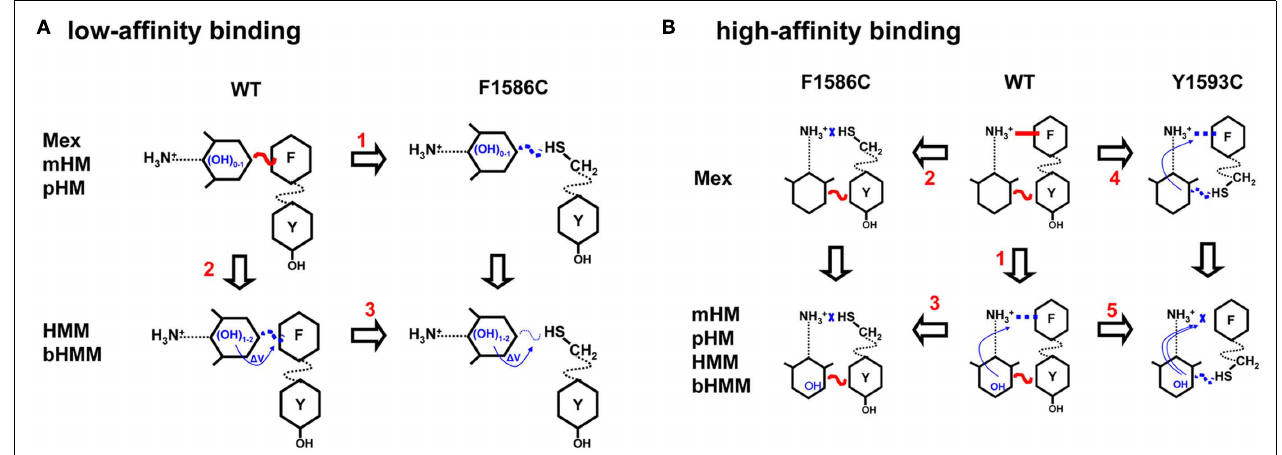
parameters (arrow 2).The F1586C mutation produces additional weakening of the interaction with HMM and bHMM (arrow 3). Finally theY1593C mutation has no effect on low-affinity binding (not illustrated). (B) Regarding the high-affinity binding to inactivated channels, addition of OH groups to the aryloxy moiety cooperatively reduced the interaction of charged amine group with F1586 (arrow 1).The amplitude of this effect depends on the OH position and lipophilicity.The F1586C mutation disrupts the π –cation interaction, so that OH substitutions have no more influence on binding (arrow 2 and 3). In contrast, theY1593C mutation impairs only partially the π –cation interaction of mexiletine through cooperativity (arrow 4).The mutation also further impairs the binding of hydroxylated analogs (arrow